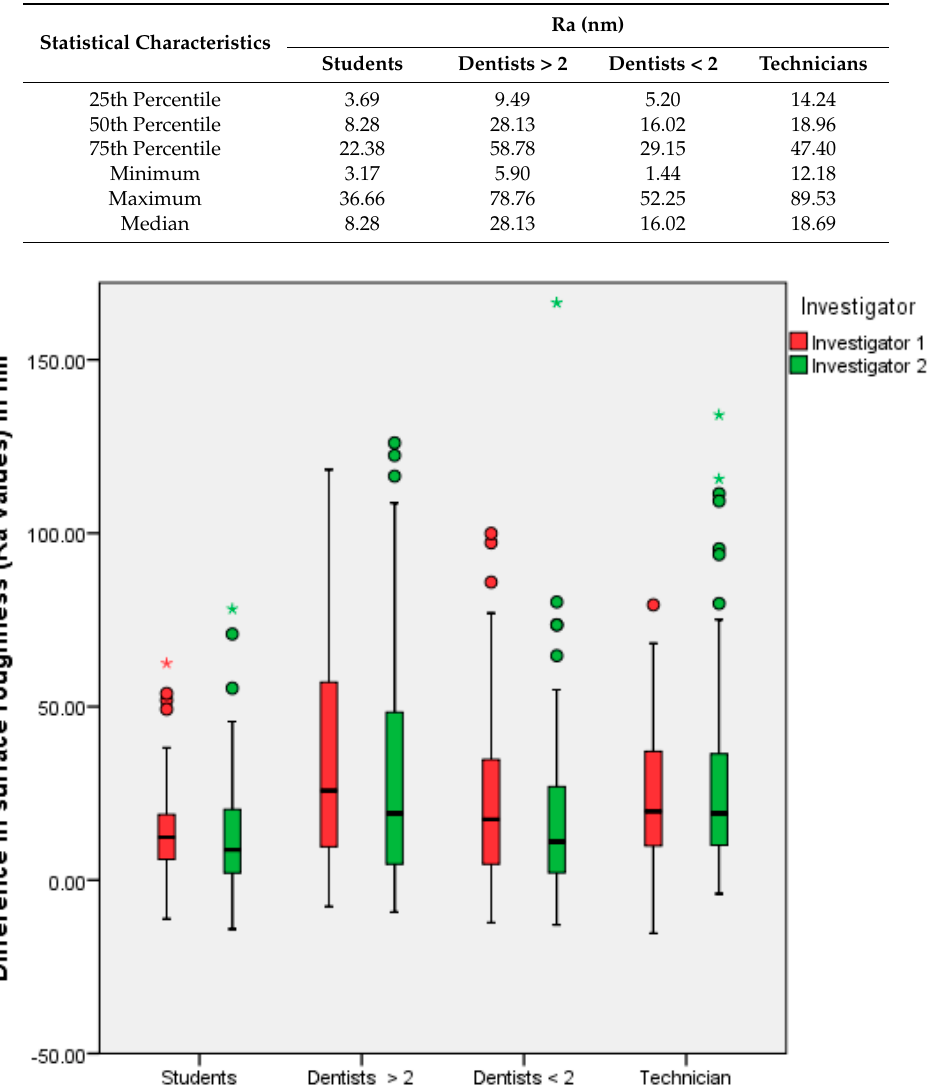
Table 4. Descriptive analysis of the Ra values (nm) of investigator 2 and trial two achieved by the specific practitioner groups